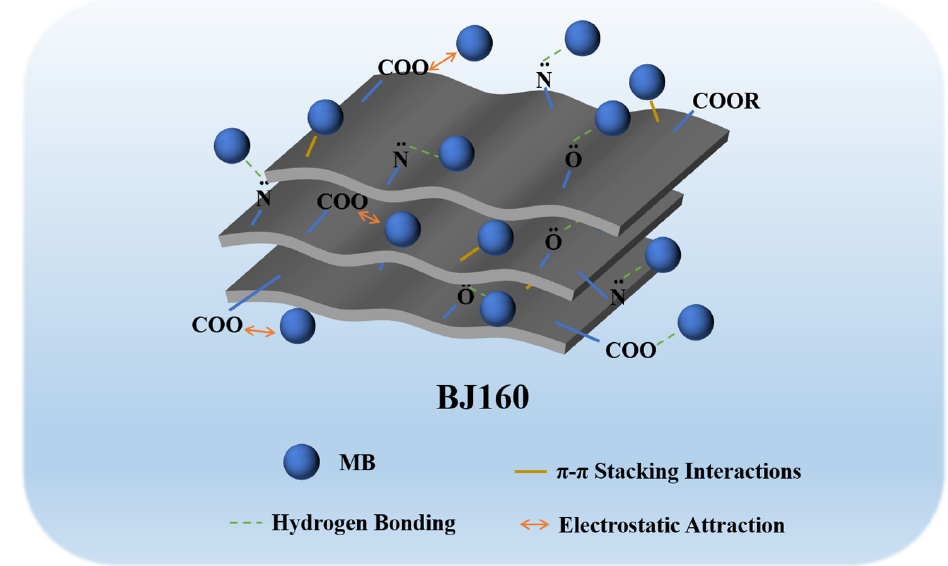
Figure 6. A proposed mechanism for MB adsorption by BJ160.